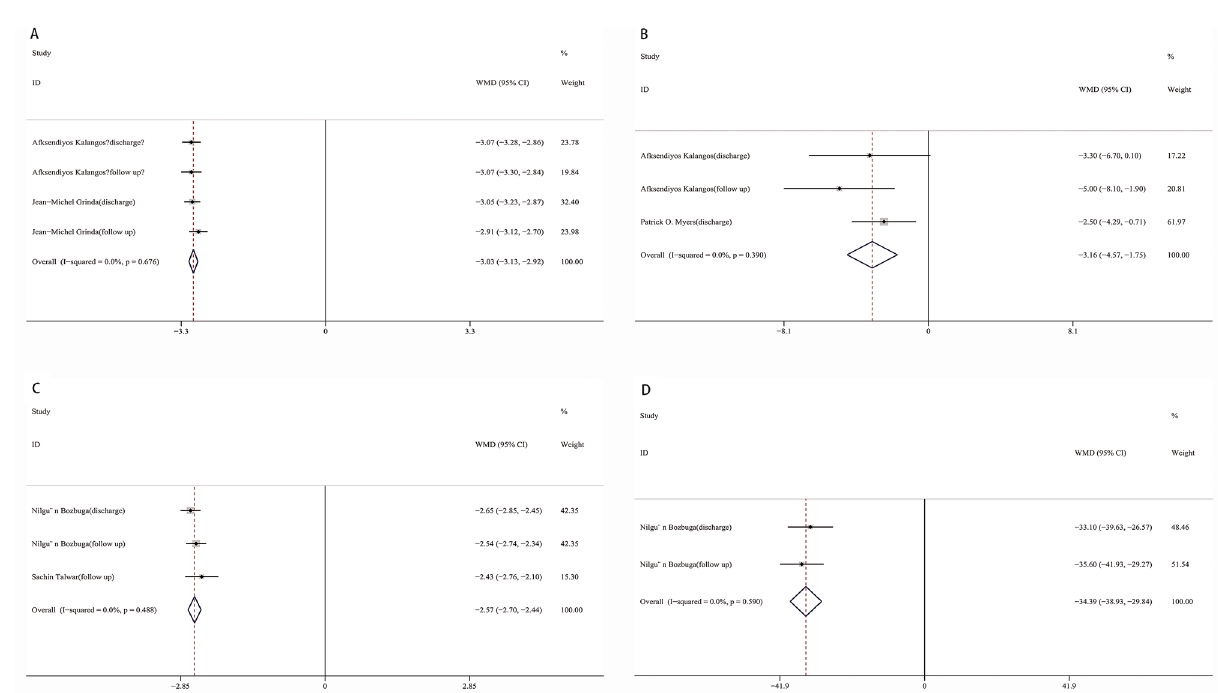
Figure 4. Subgroup analysis of AIG and AVG between pre- and post-operation: ( A ) AIG in European group; ( B ) AVG in European; ( C ) AIG in Asian group; ( D ) AVG in Asian group. WMD weighted mean differences, CI confidence